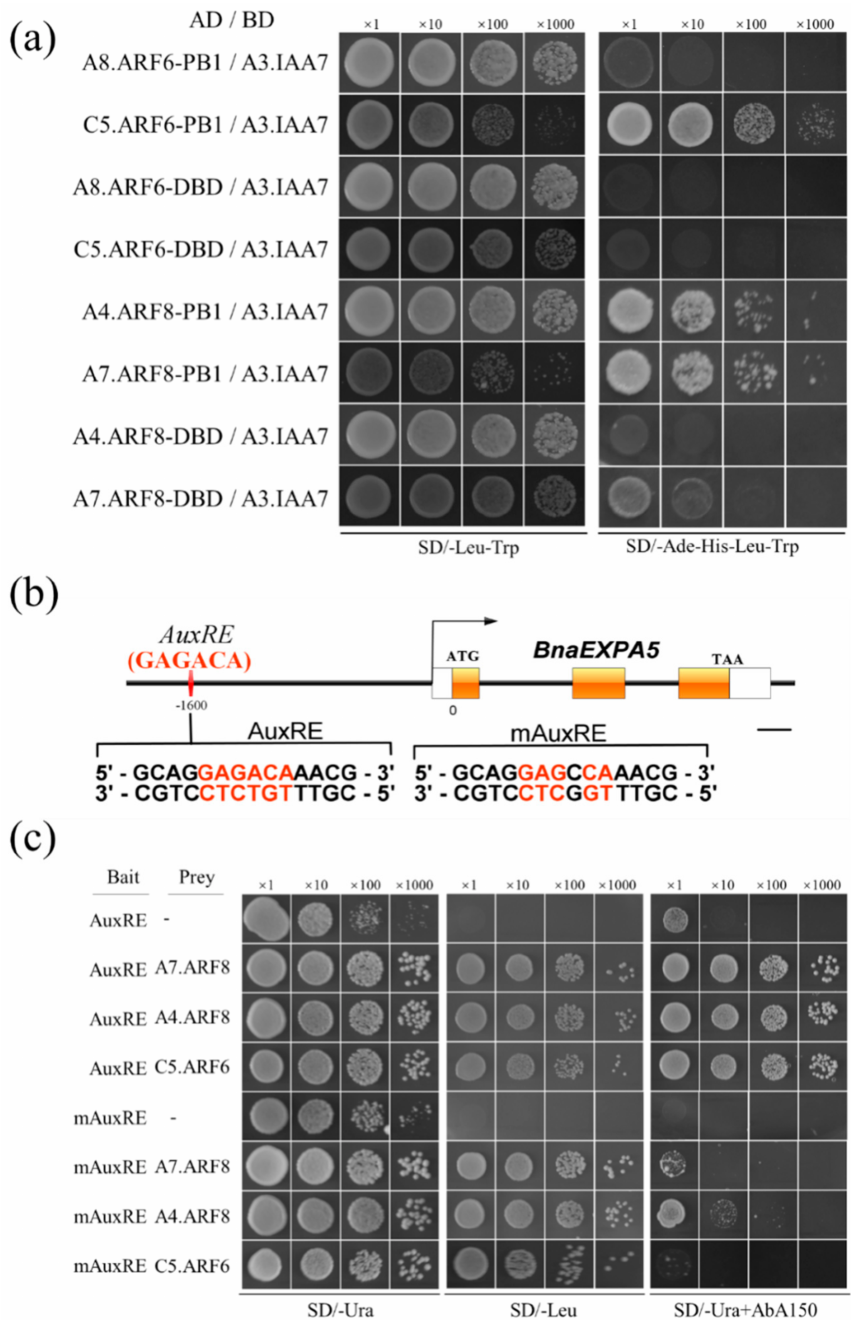
Figure 5. Analysis of BnaARF6/BnaARF8- and BnaA03.IAA7-mediated transcriptional regulation of BnaEXPA5 . ( a ) Y2H assays to analyze the interaction between BnaARF6/BnaARF8 and BnaA03.IAA7. ( b ) BnaEXPA5 gene structure and AuxRE cis-element on promoter. The white and orange boxes represent the UTR and exon of the gene, respectively, and the upstream sequence and intron are represented by solid black lines. Sequences of AuxRE and mutant mAuxRE used to construct bait vectors for Y1H are shown, (bar = 200 bp). ( c ) The binding activity of DBD domain of ARF6/ARF8 to AuxRE or mAuxRE was analyzed by Y1H assays. The serially diluted yeast cultures were spotted onto plates SD/ − Ura ( left ), SD/ − Leu ( middle ) and SD/ − Ura + 150 ng/mL AbA ( right ), and growth of the colonies was photographed at 3 days after the spotting. The abbreviations PB1, DBD, A3.IAA7, A8.ARF6, C5.ARF6, A4.ARF8, A7.ARF8 indicate Phox and Bem1 Domain, DNA Binding Domain, BnaA03.IAA7 BnaA08.ARF6, BnaC05.ARF6, BnaA04.ARF8, and BnaA07.ARF8,